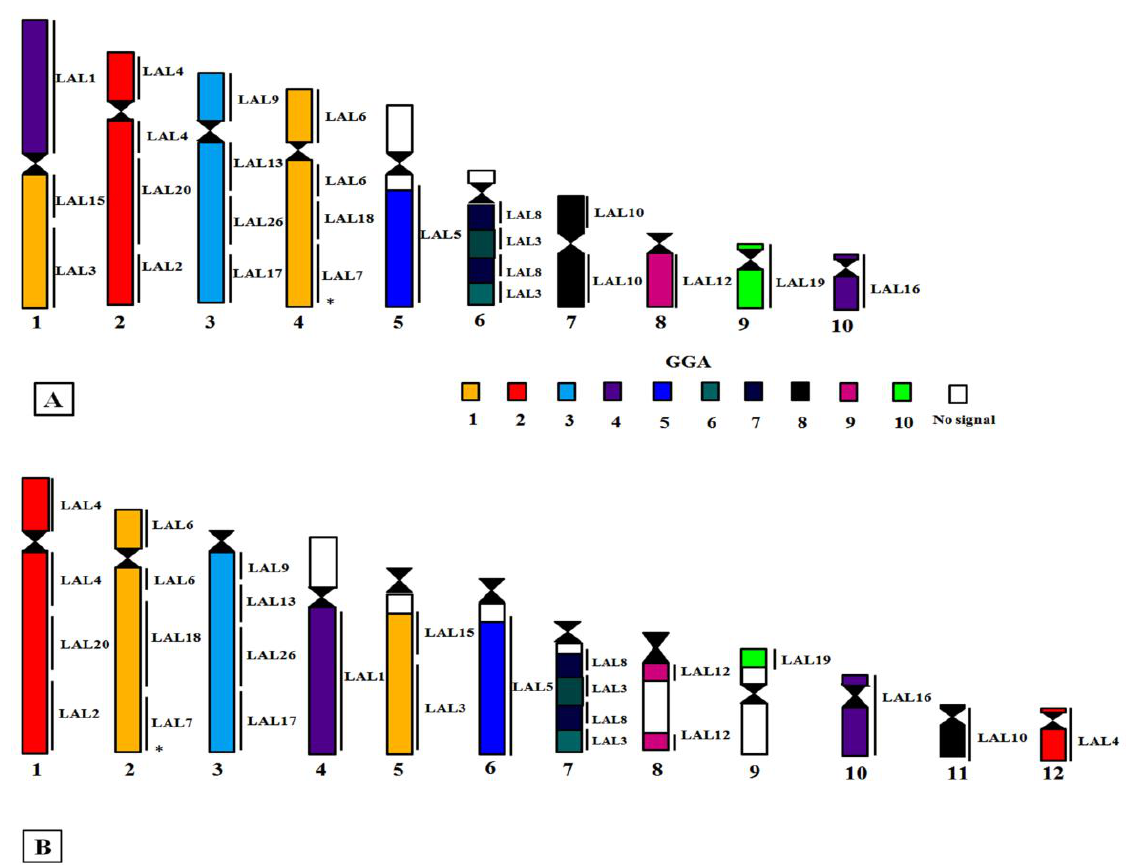
Figure 4. Homology maps with GGA and LAL probes in metaphasic chromosomes of ( A ) Pyrrhura frontalis and ( B ) Amazona aestiva . Segments not hybridized with LAL probes are indicated with asterisks.